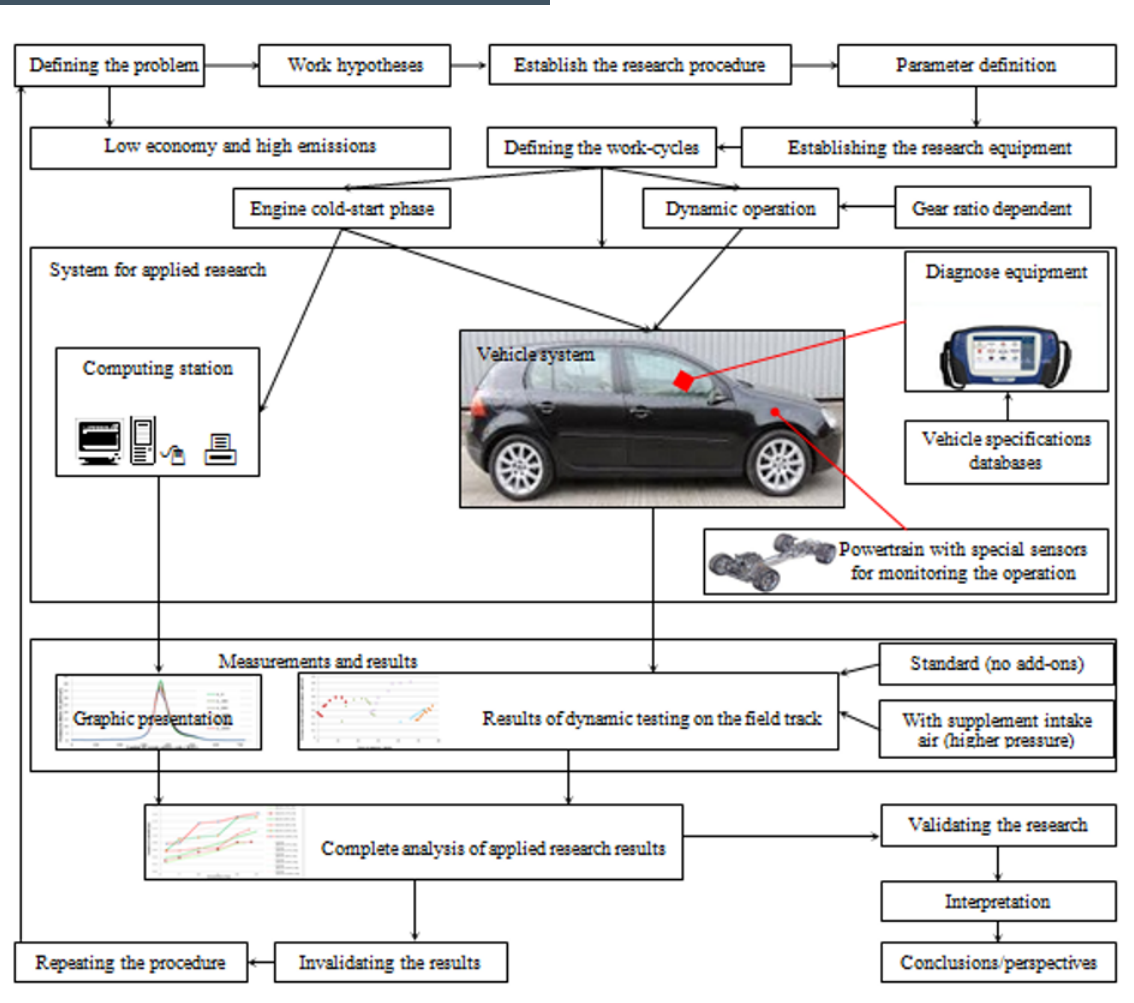
Figure 3. Complete methodology and experimental setup.